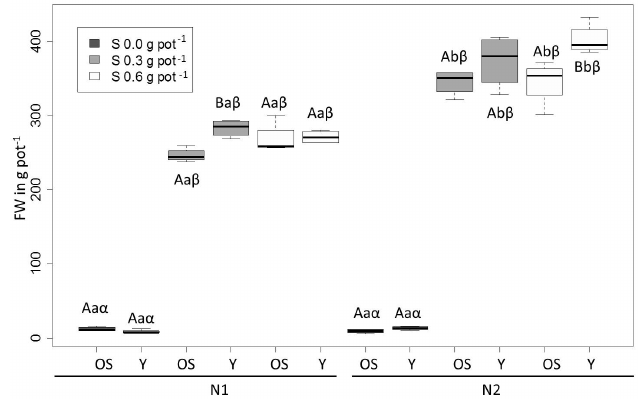
Fig. 2: Fresh weight (FW) of the cvs. orient Surprise (OS) and Yuki (Y) in dependency to the N (1.0 and 2.0 g pot -1 ) and S (0, 0.3 and 0.6 g pot -1 ) supply. N1, 1 g pot -1 ; N2, 2 g pot -1 . Uppercase letters represent significant differences between the cvs., lower case letters represent significant differences between the N treatments, and Greek letters significant differences between the S treatments (P < 0.05).